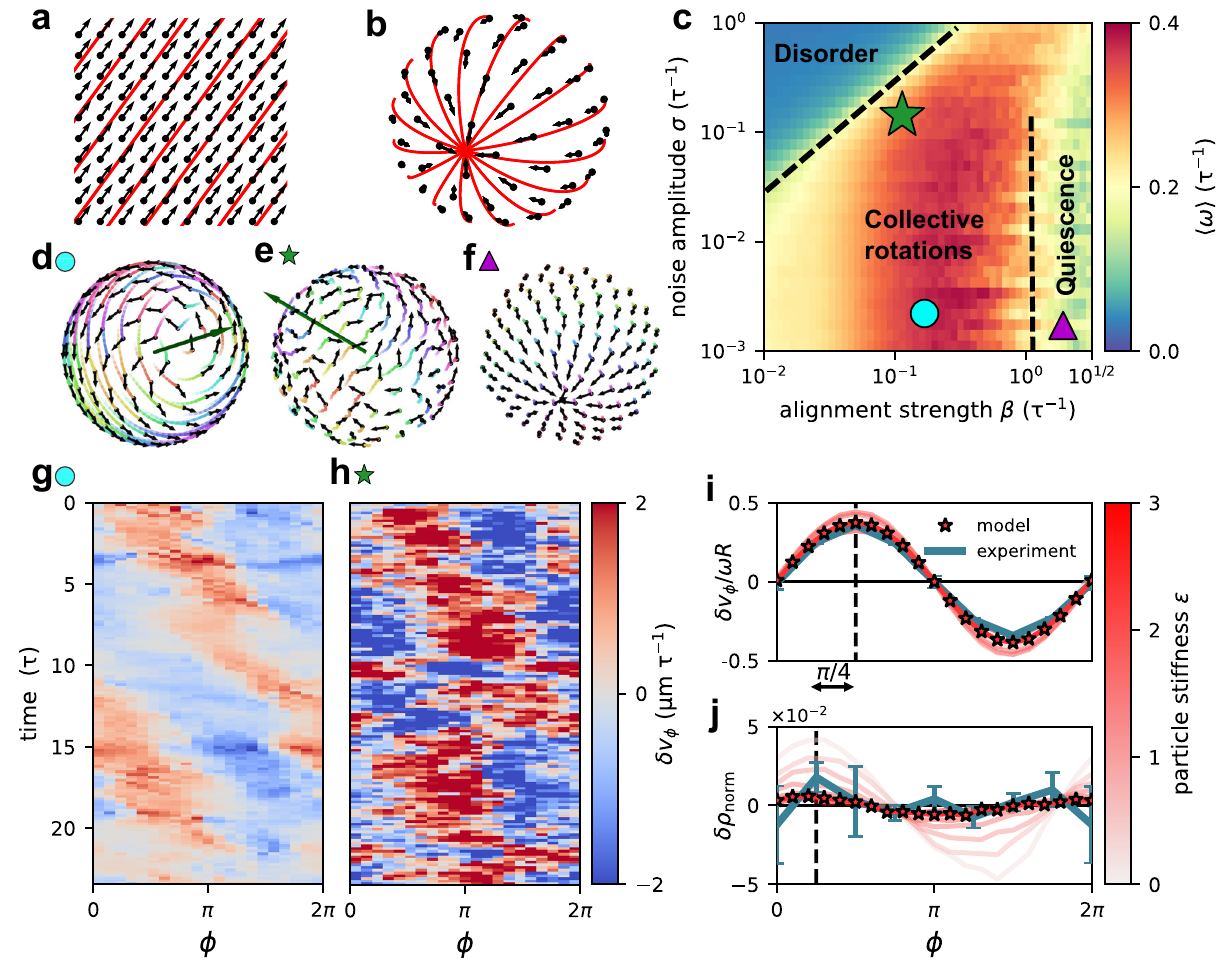
Fig. 4 | Velocity waves in a model for active particles on a sphere. a , b Ground Black vectors are particle polarities, trajectories are plotted ascolored lines fading overtime(SupplementaryMovies3,4).Thegreenvectorshowstheaxisofrotation states of an aligning vector fi eld on a fl at surface ( a ) and on a sphere ( b ). Both are ofthesphericallayerofactiveparticles. g , h Representativekymograph δ v ϕ ϕ , t ð Þ of found by implementing alignment interactions between vectors at fi xed positions. Redlinesshowachosensetofgeodesics.Onasphericalsurface,noglobalorderin a velocity wave predicted by our model in the regime of low noise collective a vector fi eld is possible and different geodesics intersect. c Phase diagram of rotation ( β =0 : 32, σ =0 : 006) ( g ) and for the experimental parameter values ( h ). i , j Average rescaled velocity wave pro fi le δ v ϕ = ω R ( i ), and average weakly compressible ( ϵ =2) active aligning particles constrained to a sphere con- structed from the average angular speed h ω i . The simulationtimescale τ isde fi ned : The green star indicates the para- through the speed of self-propulsion: τ = 1 μ m v 0 meter value ( β =0 : 1, σ =0 : 4), where the model quantitatively reproduces the rotationaldynamicsmeasuredexperimentally.Blackdashedlinessuggestapparent phaseboundaries. d – f Snapshotsof predictedstatesmarked inthe phasediagram.